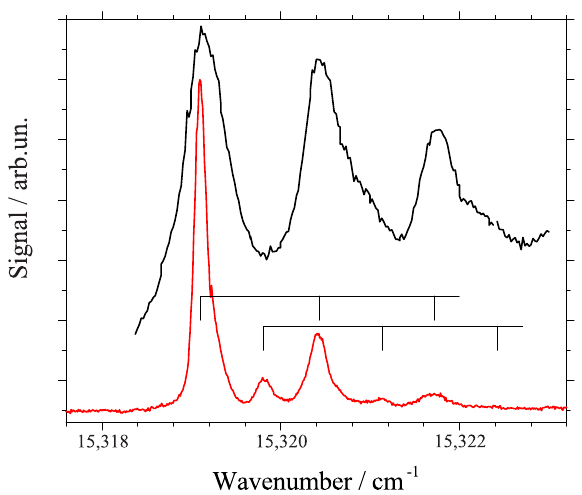
Figure 7. Electronic origin of the fluorescence excitation spectrum of AlCl-phthalocyanine in helium droplets recorded with laser intensity beyond (black line) and below (red line) the saturation limit. Below saturation limit, a fine structure is resolved which consists of two triple peak features as indicated by two combs. For details see